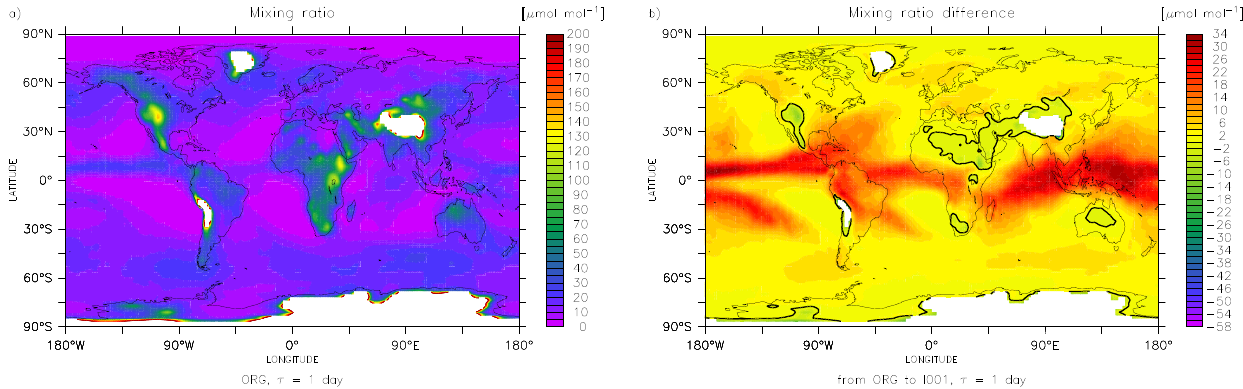
Figure 1. Horizontal distribution of the decaying scalar with a lifetime of 1day, averaged over 2001 at 700hPa. Shown are (a) the distribution for the ORG numerical experiment and (b) the mixing ratio difference for I001 compared to